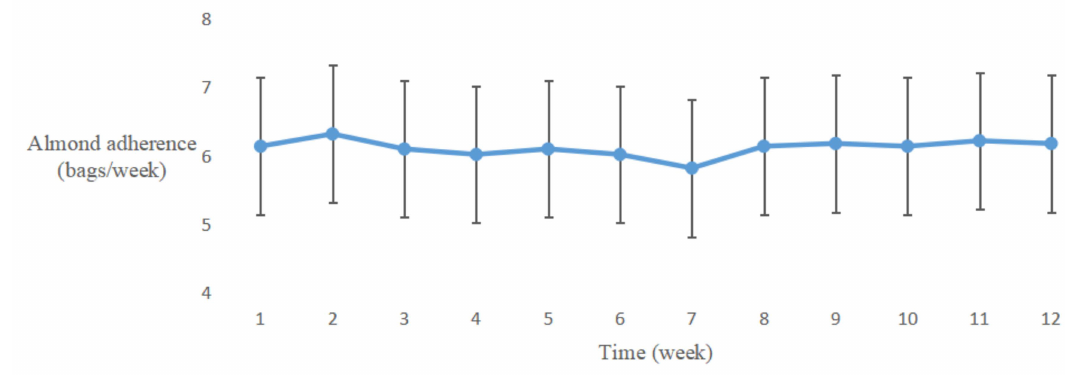
Figure 3. The changing trends of almond adherence in the a-LCD group.